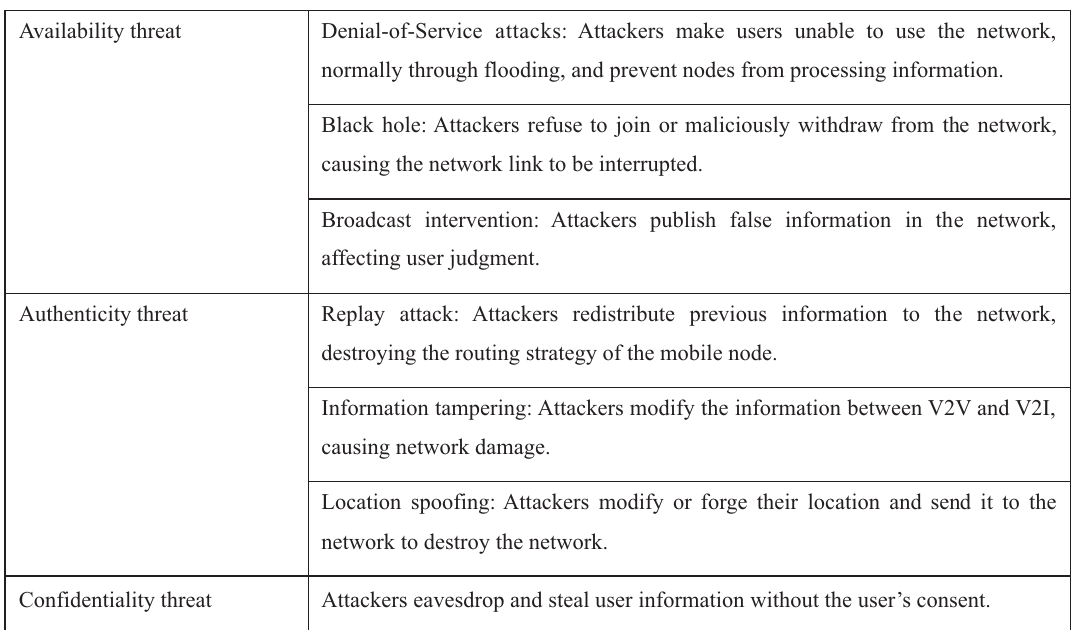
Table 1. Main threats faced by the